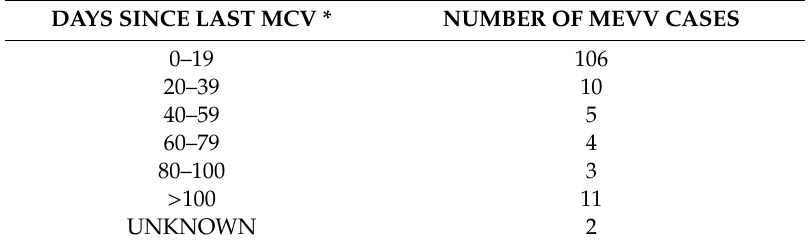
Table 3. Count of measles vaccine virus detections and days from most recent measles-containing vaccine. DAYS SINCE LAST MCV *